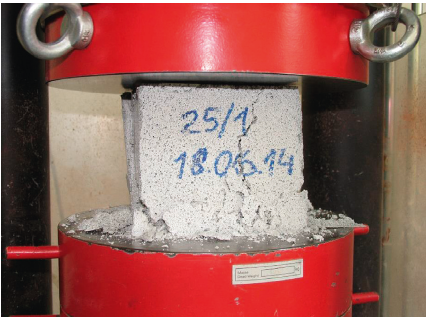
Figure 2: Typical failure pattern observed during compression tests with cube